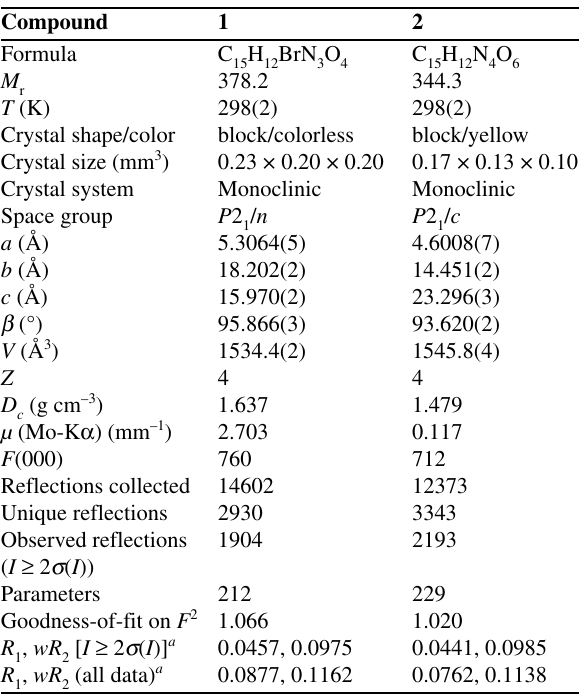
Table 1. Crystallographic and experimental data for the com- pounds